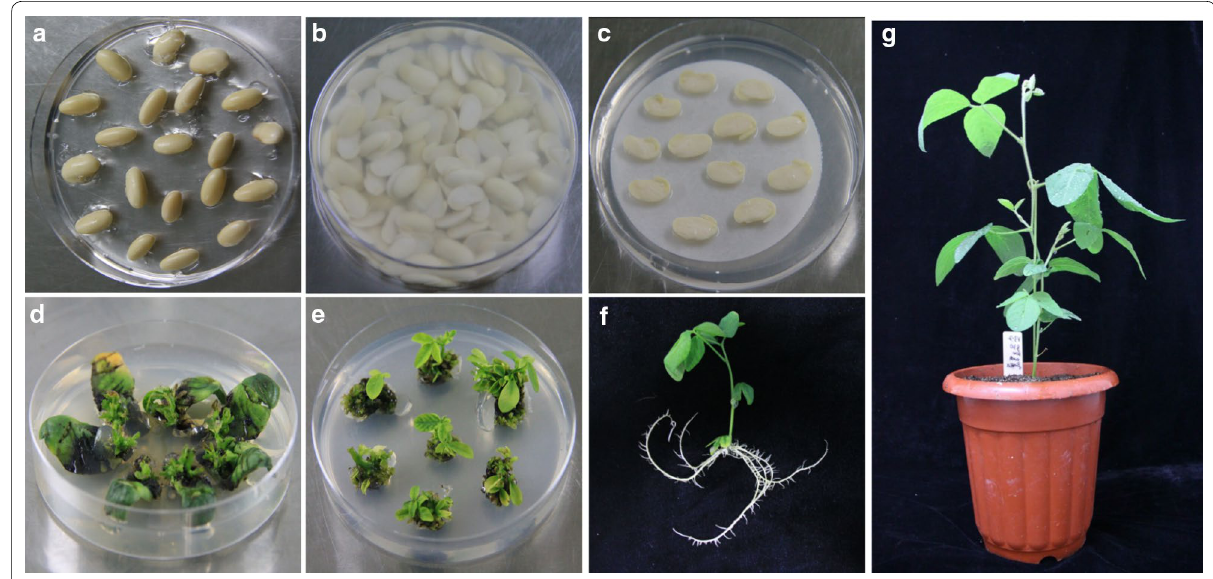
Fig. 1 Process of Agrobacterium -mediated soybean cotyledonary-node transformation. a Seeds germination. b Incubated in LCCM. c Co-cultivation. d Shoot induction. e Shoot elongation. f Rooting. g Seedling